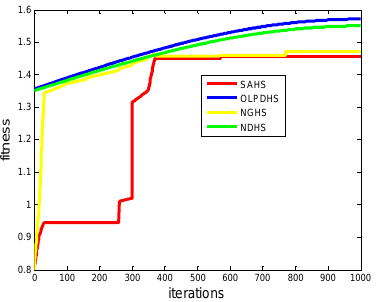
Figure 8. The convergence curves of fitness of two algorithms.